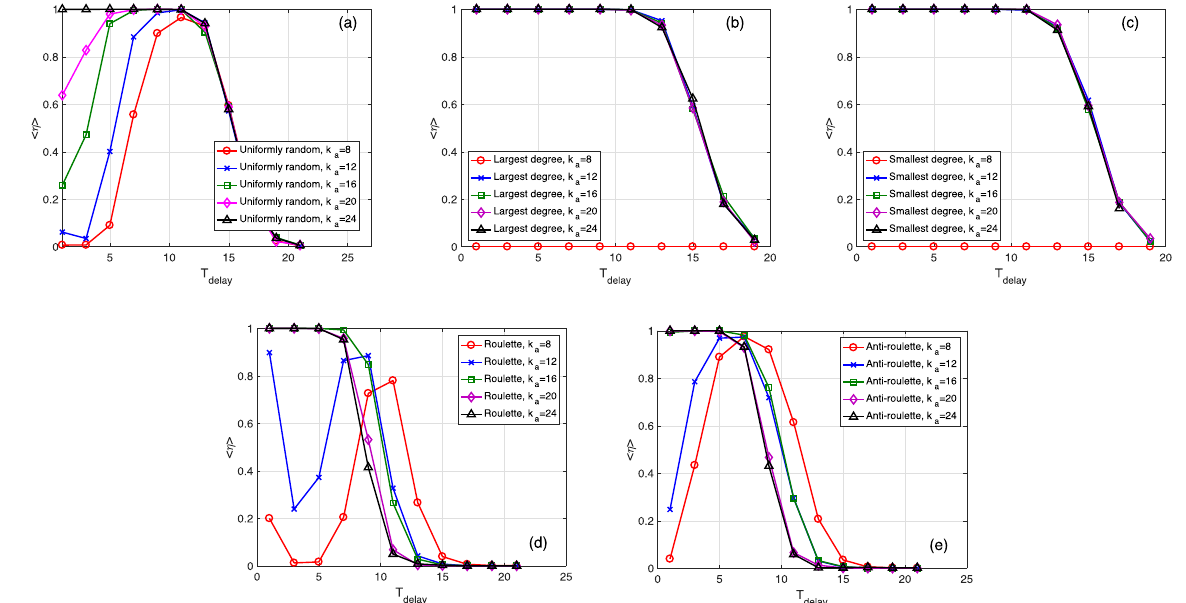
Figure 5. Mean survival ratio 〈 η 〉 as a function of T delay for N a = 100 and different k a values. ( a ) SF networks with the uniformly random selection. N = 1000, M = 3000, M a = 10, γ = 1.8, k s = 5, q = 0.39, and f = 0.2. The threshold for determining a total collapse is d = 0.1. ( b–e ) Similar to (a) but for the largest degree, smallest degree, roulette, and anti-roulette selection rules.